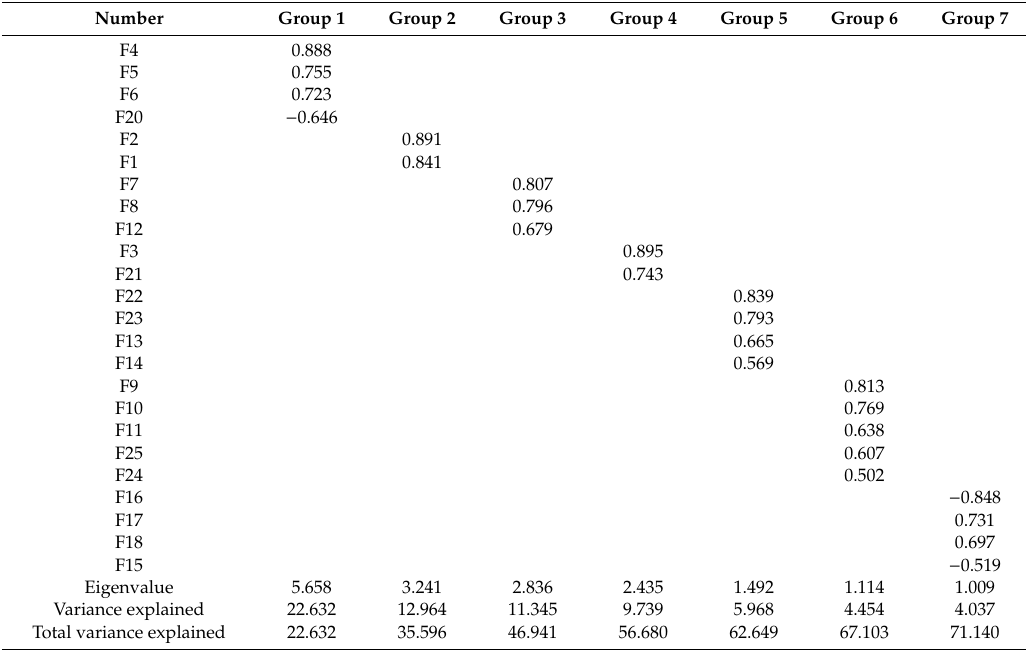
Table 3. Analysis results of exploration factor analysis